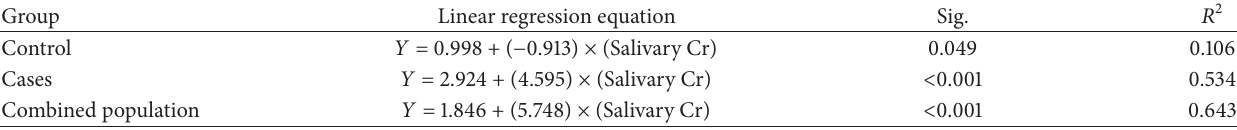
Table 3: Table showing linear regression analysis of serum and salivary creatinine for controls and CKD patients.